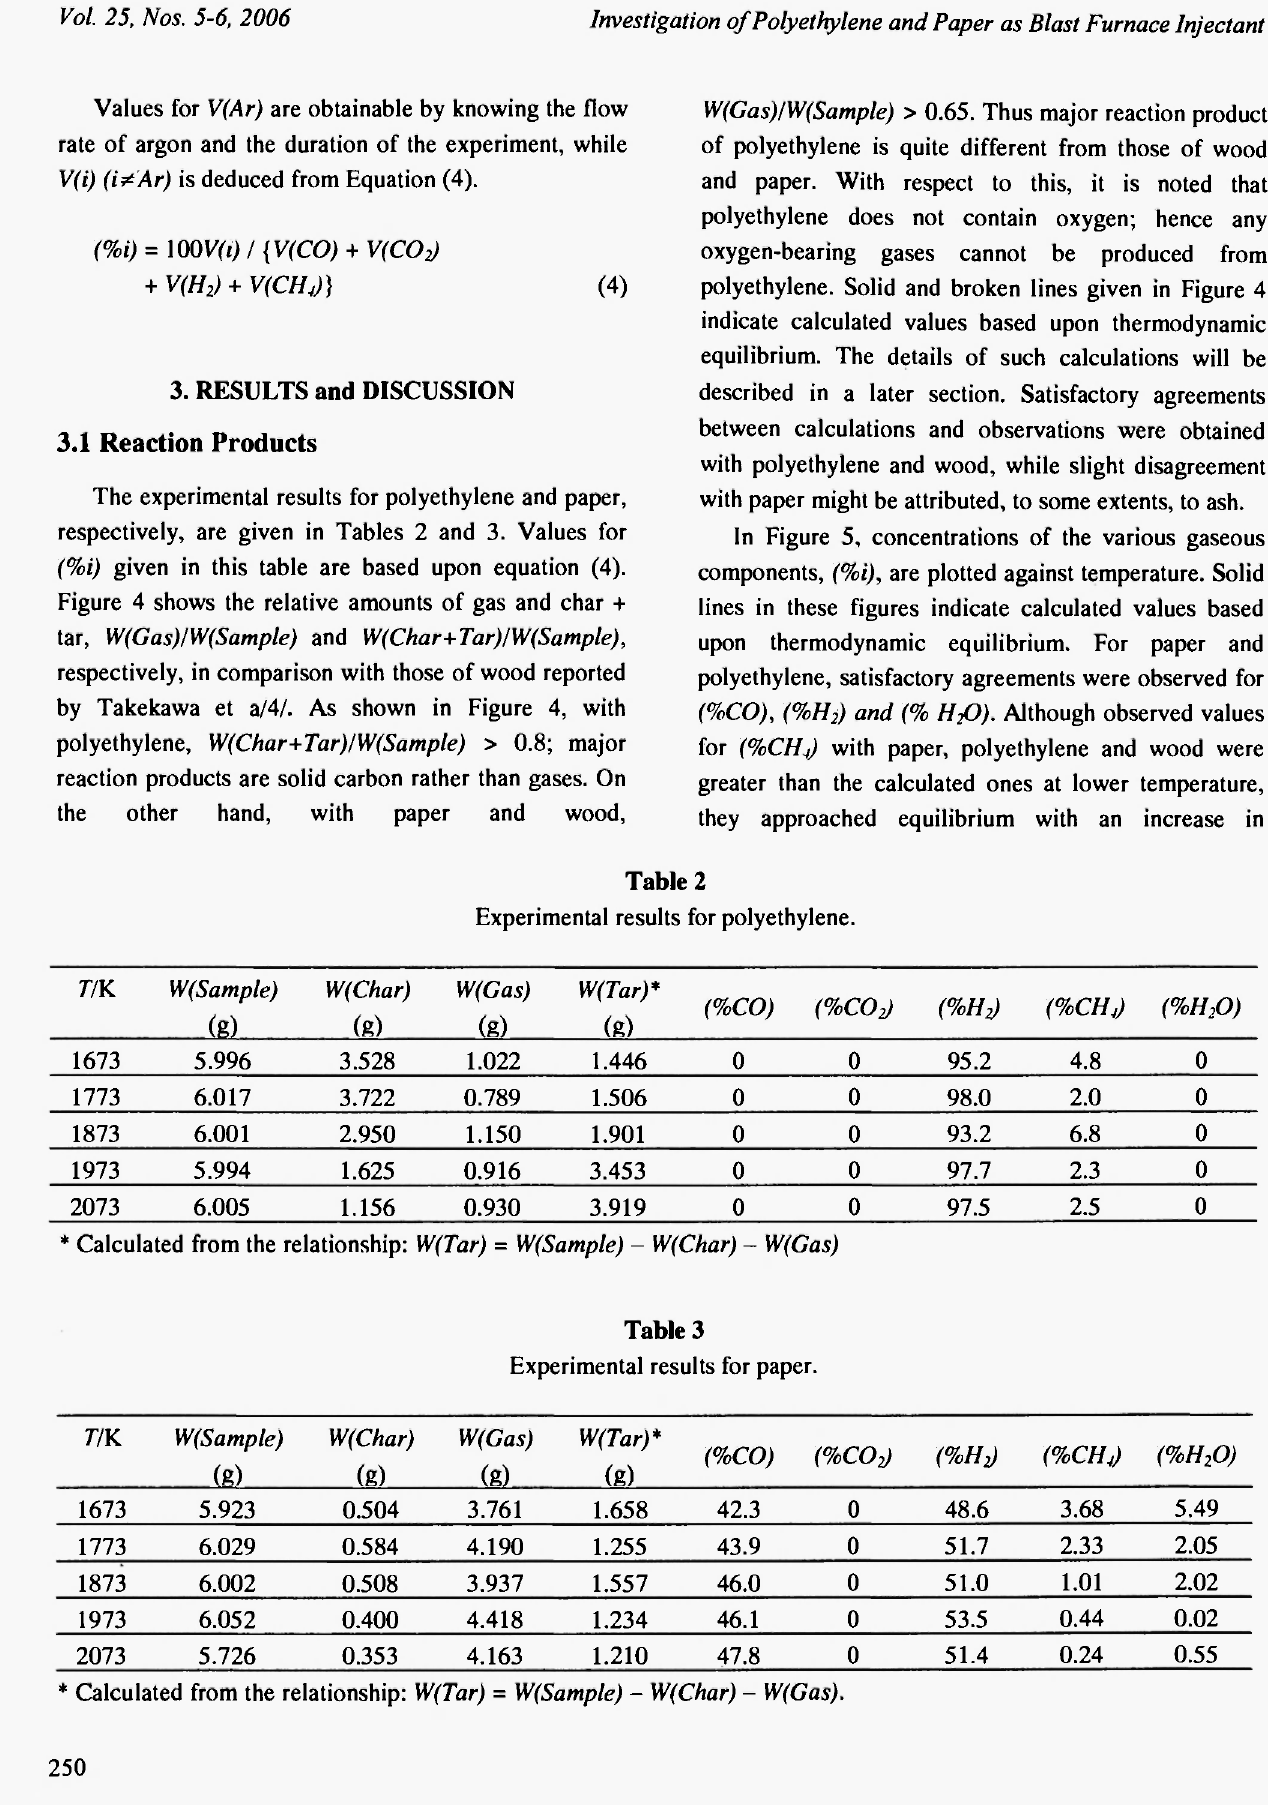
Experimental results for